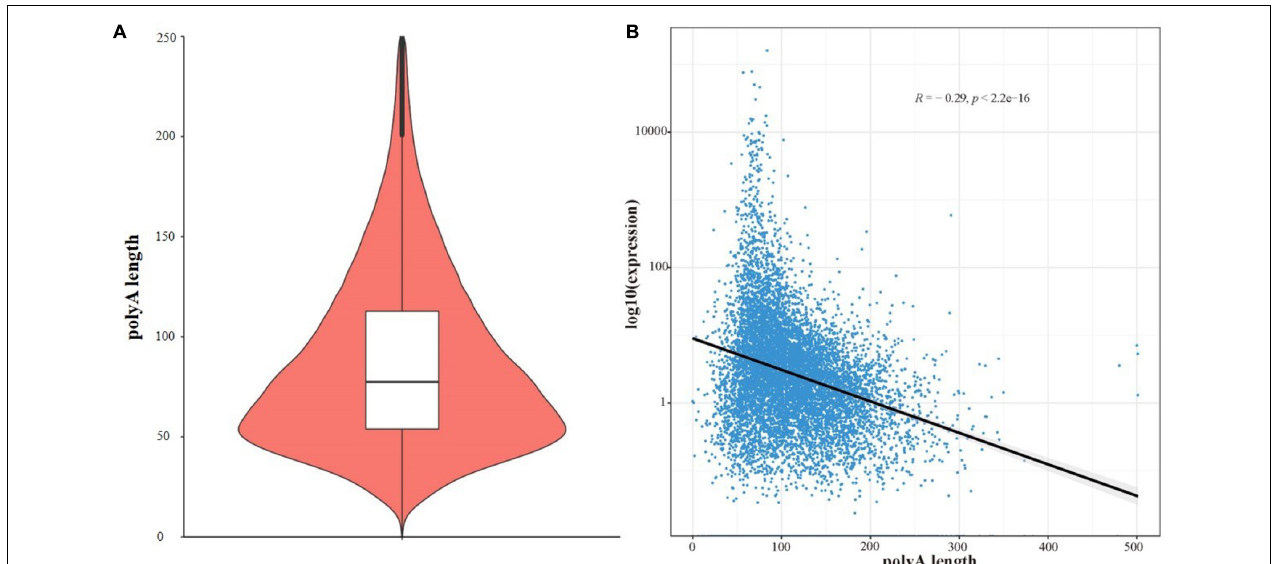
FIGURE 6 | (A) The length distribution of polyAs. (B) The correlation between polyA N50 and expression level of FL transcripts.